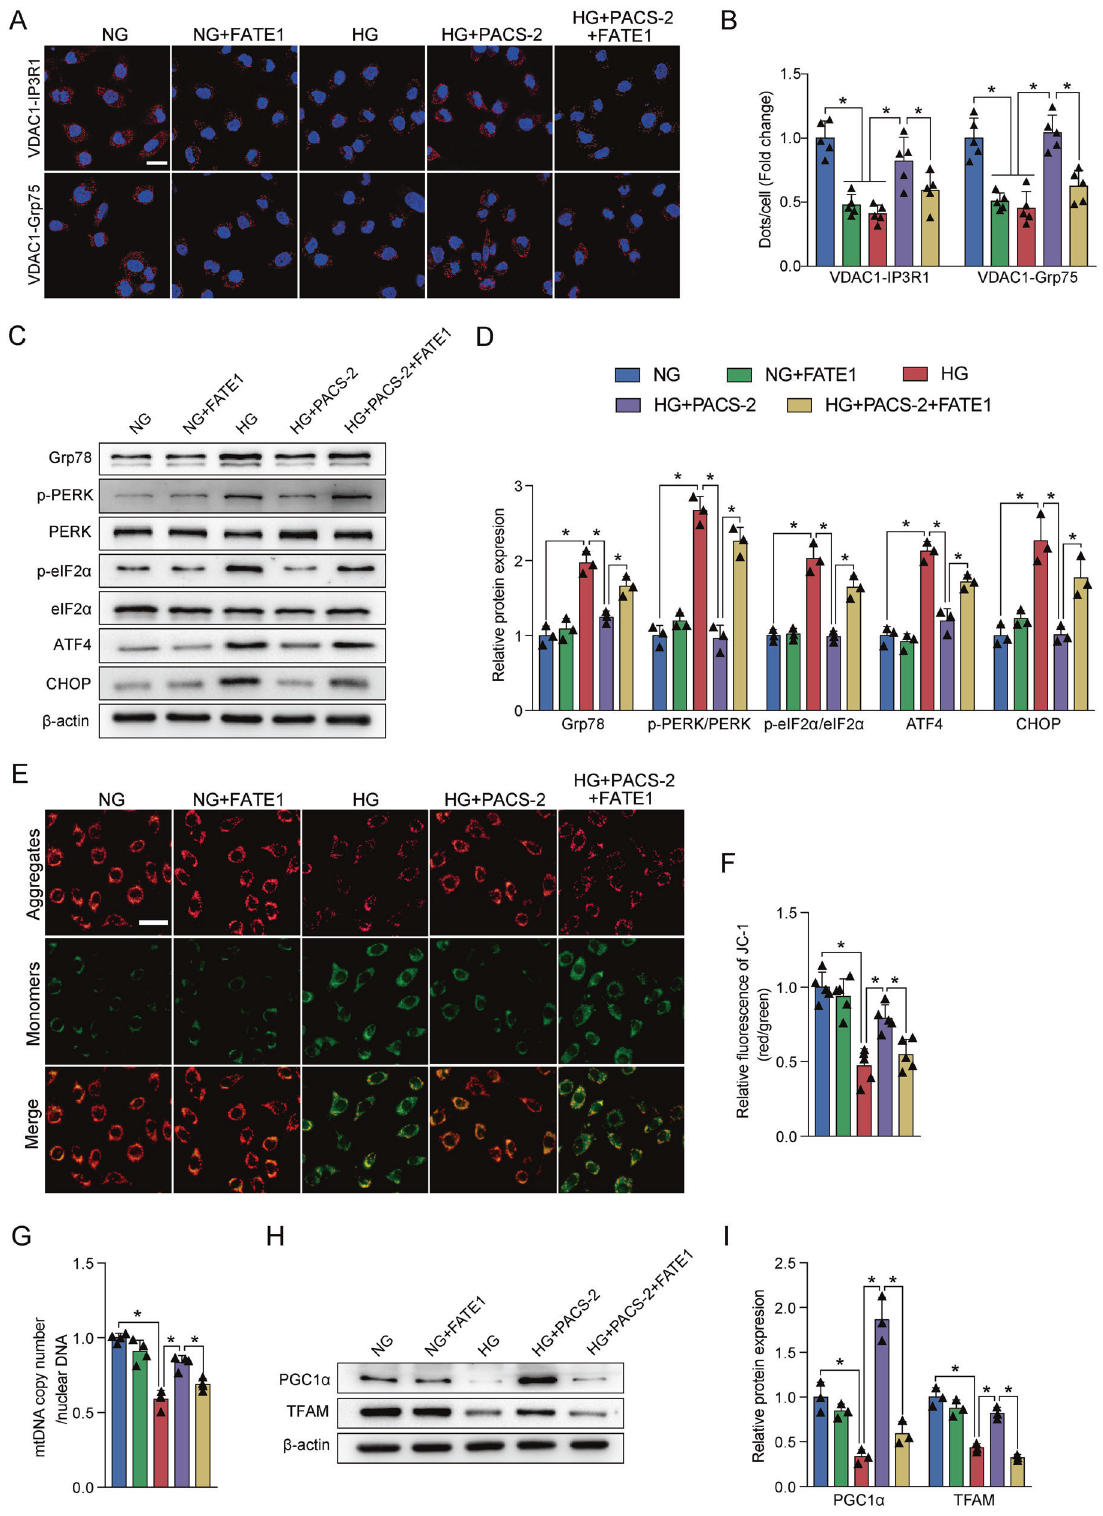
Fig. 7 Experimental uncoupling ER-mitochondria interactions impaired the effects of PACS-2 overexpression on MAM homeostasis, HG- induced ER stress, and mitochondrial dysfunction. A Representative in situ PLA images showing the VDAC1/IP3R1 or VDAC1/Grp75 complexes in HK-2 cells. Scale bars = 50 μ m. B Quantitative analysis of in situ PLA dots in A . n = 5. C Western blot bands of Grp78, p-PERK, PERK, p-eIF2 α , eIF2 α , ATF4, and CHOP in HK-2 cells. D Quantitative analysis of indicated protein levels in C . n = 3. E Mitochondrial membrane potential in HK-2 cells measured by JC-1 dye. Scale bar = 50 μ m. F Quantitative analysis of JC-1 red fl uorescence to JC-1 green ratio in E . n = 5. G Measurement of mtDNA copy number normalized to nuclear gene in HK-2 cells. n = 4. H Western blot bands of TFAM and PGC1 α in HK-2 cells. I Quantitative analysis of indicated protein levels in H . n = 3. All data are expressed as mean ± SD. * P <